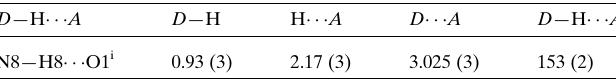
Table 1 Hydrogen-bond geometry (A˚ , (cid:2) ).